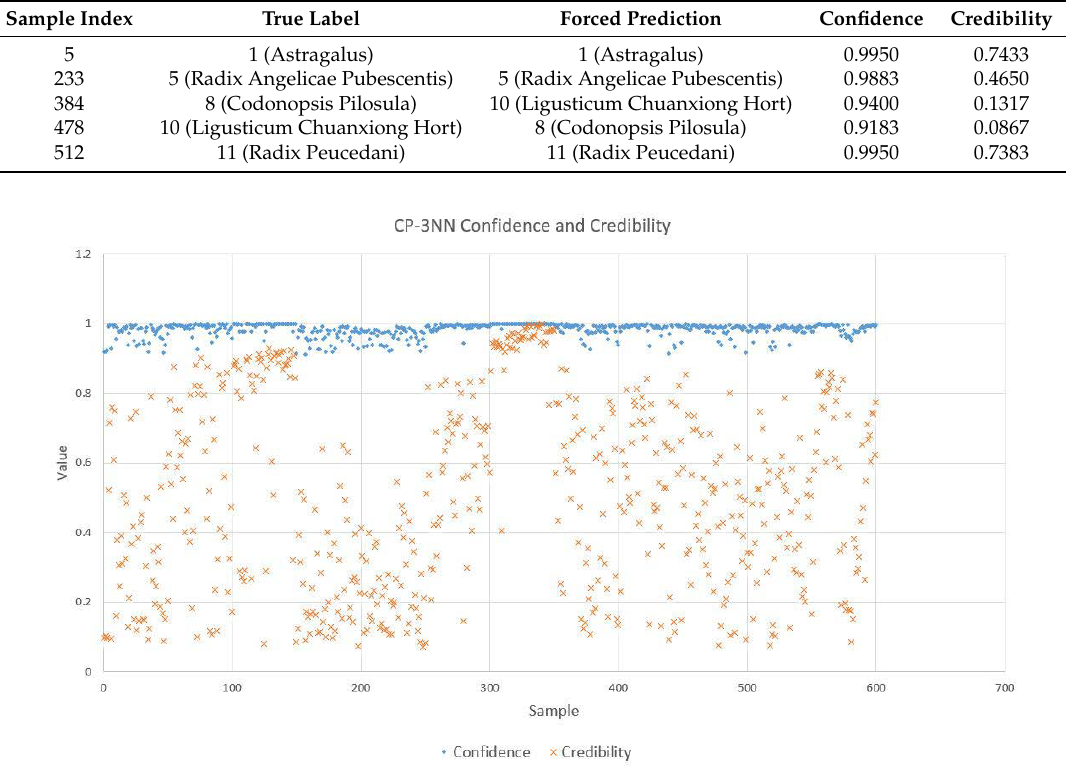
Figure 7. Confidence values and credibility levels for 12 herbal medicine classifications with CP-1NN. Table 7. Five typical individual predictions for 12 herbal medicine classifications with CP-1NN.